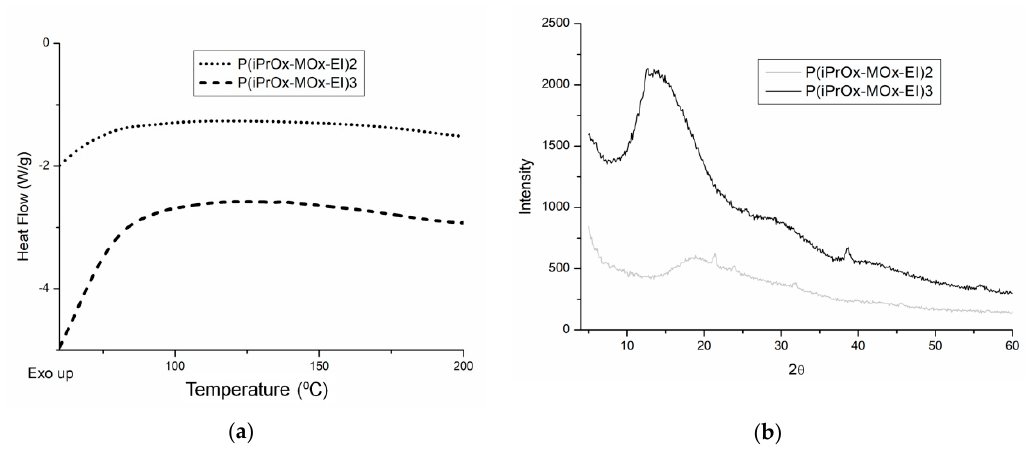
Figure 10. ( a ) DSC traces (heating rate of 10 °C/min) and ( b ) X-ray diffraction curves for iPrOx/MOx/EI copolymers annealed at 150 °C for 1 h.